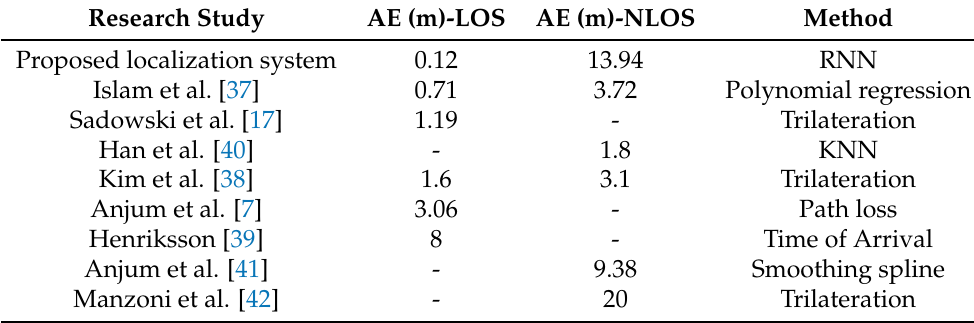
Table 3. RNN indoor localization results (LOS/NLOS) compared to results from related